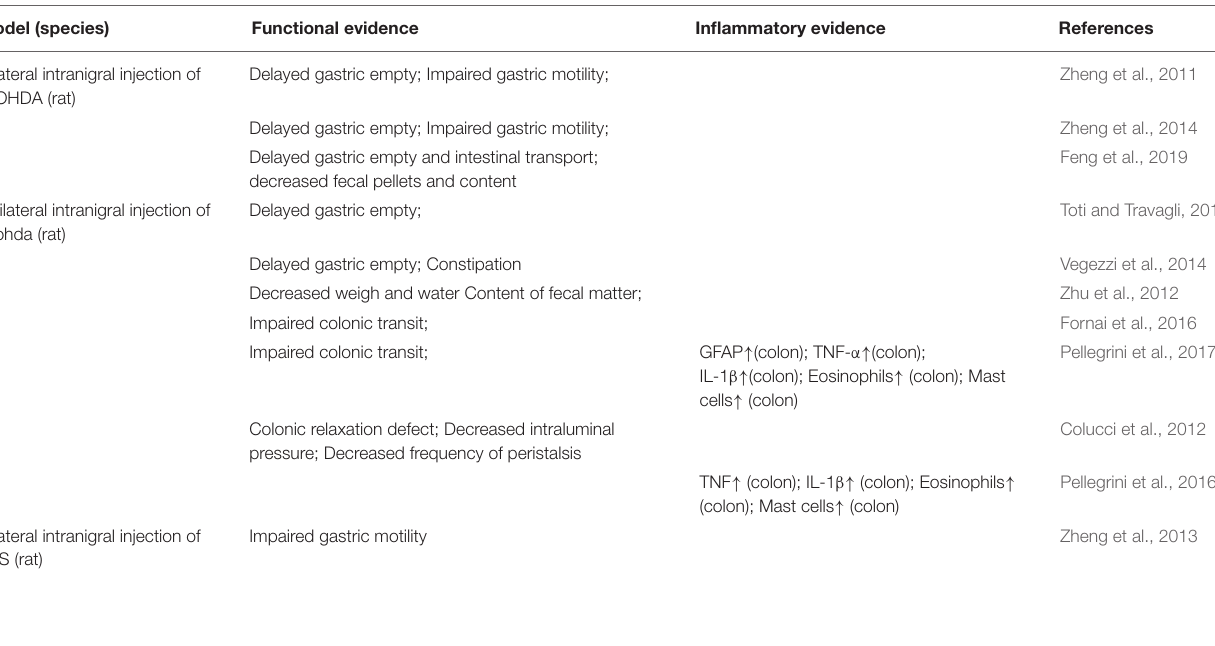
TABLE 1 | Summary of intestinal function and inflammatory alterations in Parkinson’s disease (PD) animal models of intranigral injection of 6-OHDA or LPS. Model